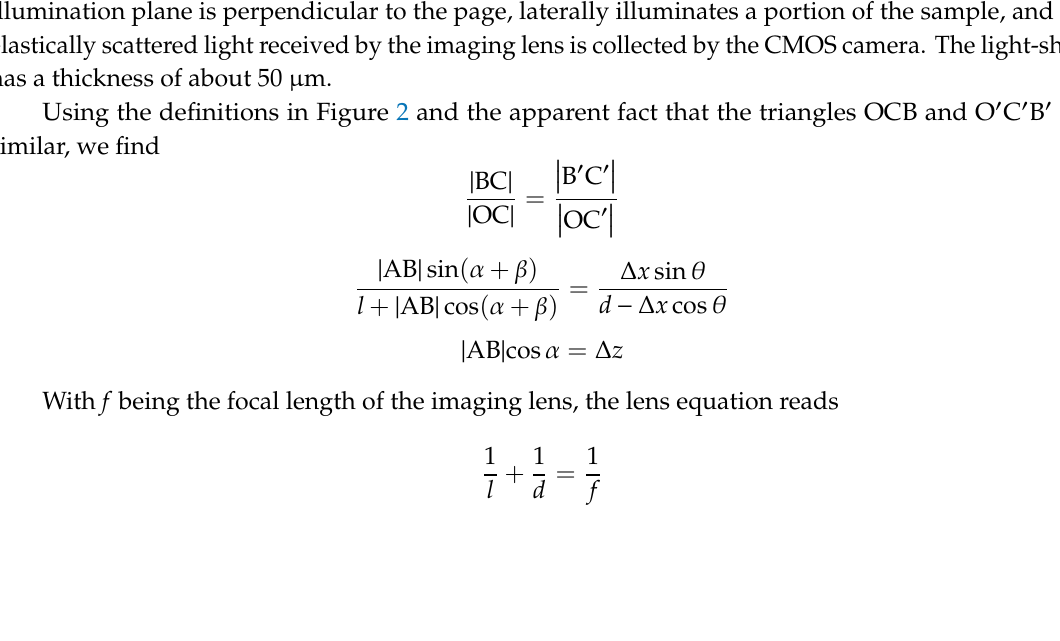
Figure 2. ( a ) Schematic diagram of the universal oblique laser triangulation. The reference surface refers to the plane of the sample to be inspected were it to be an ideal flat surface as opposed to the actual surface including surface imperfections. We refer to concavities or convexities for cases when